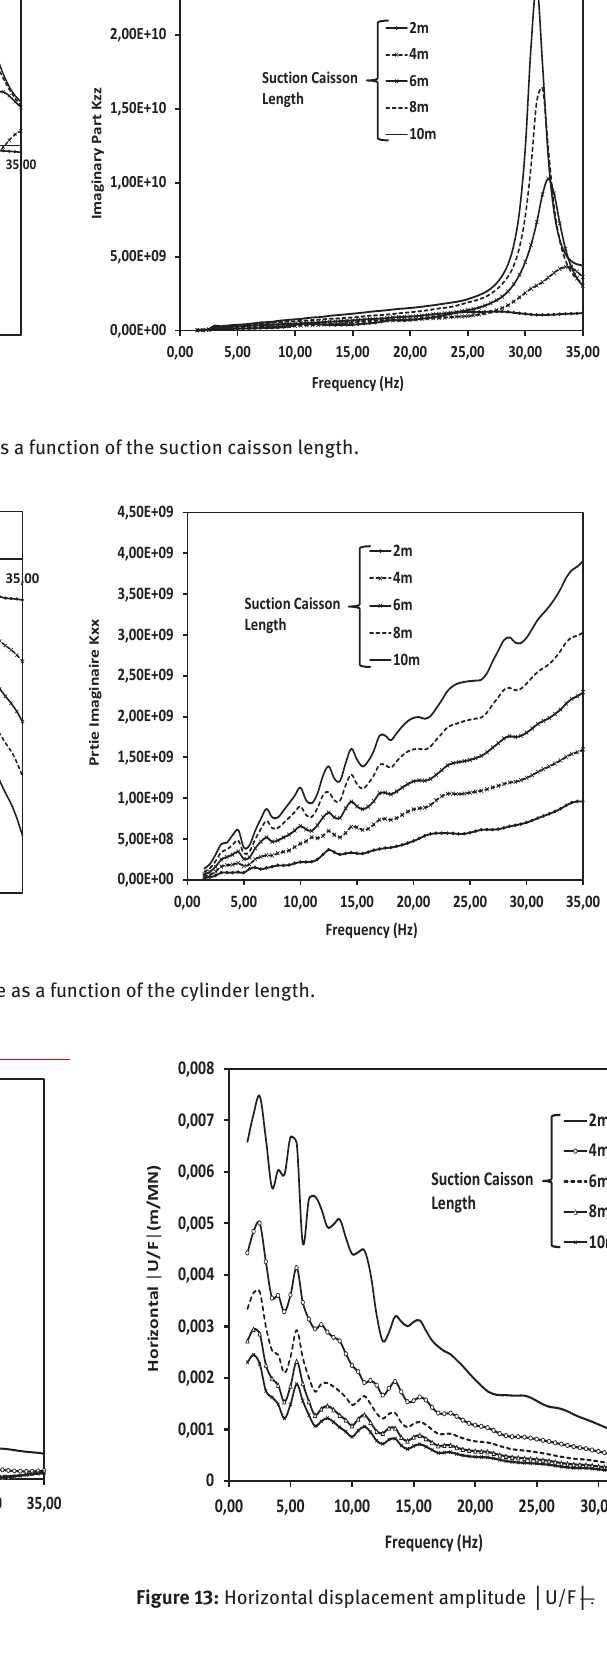
Figure 14 Vertical and horizontal response for the maximum │U/F│̶ Influence of the cylinder depth